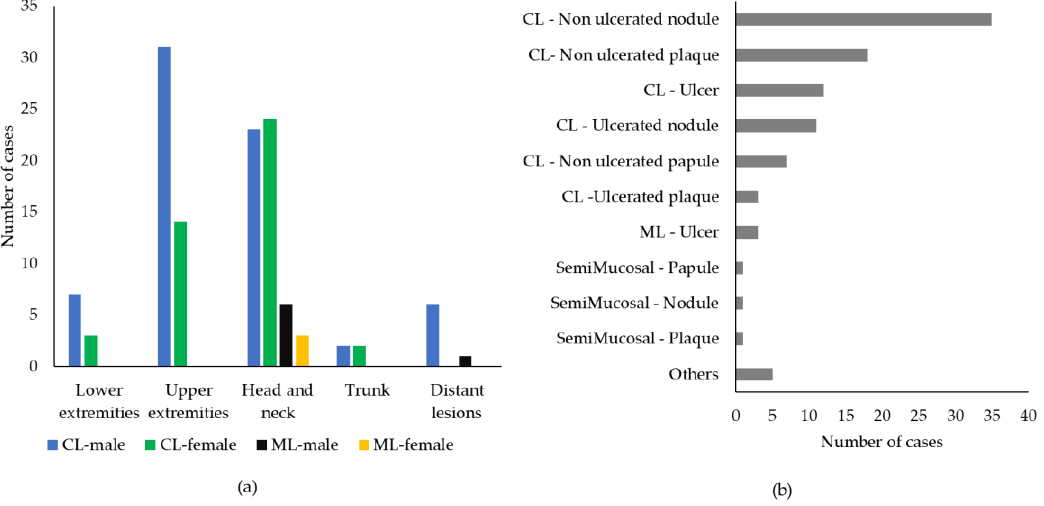
Figure 4. Clinical characteristics of tegumentary leishmaniasis cases in the Emilia-Romagna region, northeastern Italy, 2017 – 2020. ( a ) Frequency of lesions in different anatomic sites in males and females. Data were available for 124 cases of cutaneous leishmaniasis (CL) and 10 cases of mucosal leishmaniasis (ML); ( b ) frequency of different types of lesions. Data were available for 90 CL cases and 8 ML cases.